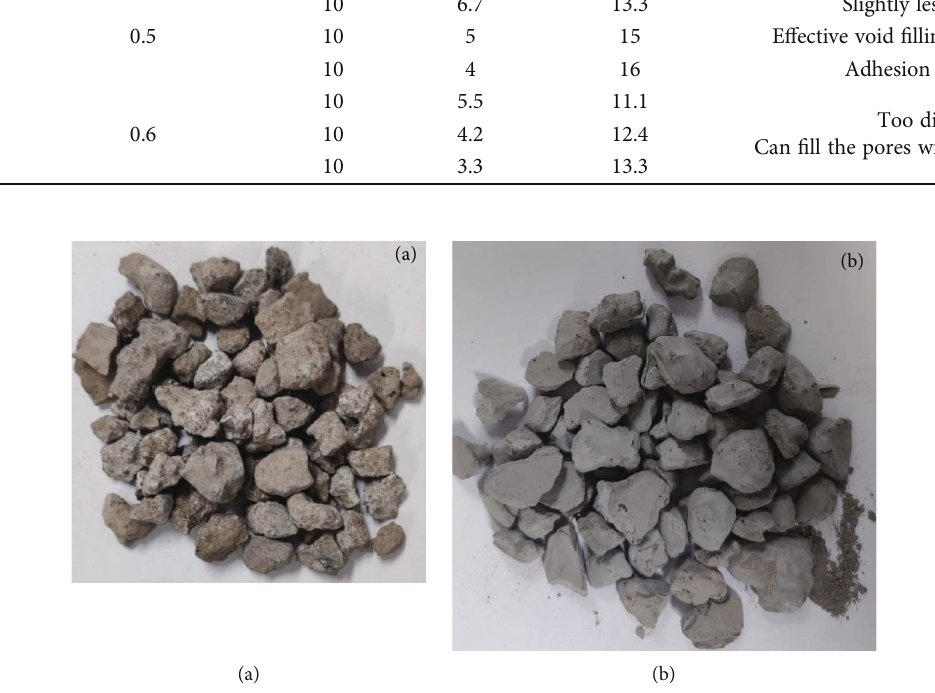
Figure 1: The morphology of (a) original steel slag and (b) modi fi ed steel slag. Table 2: Sieve results of steel slag aggregate.